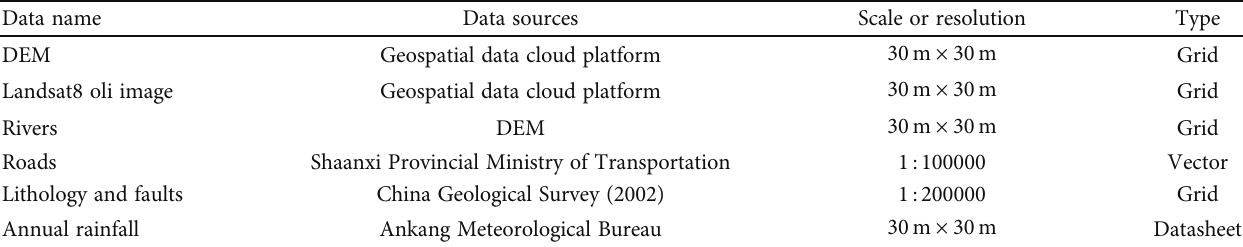
Table 1: Data and data